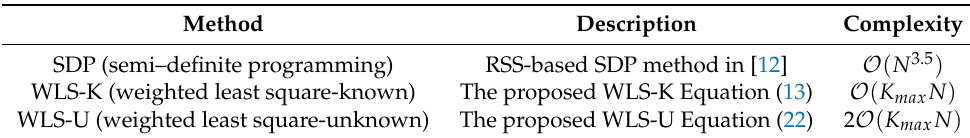
Table 1. Summary of the considered